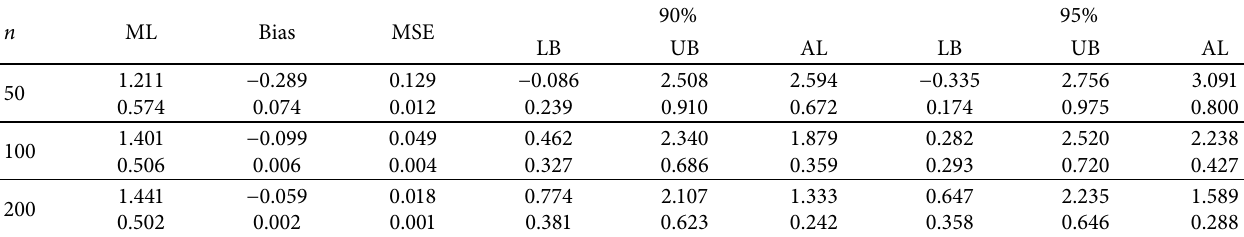
Table 1: ML estimates, biases, MSE, LB, UB, and AL of the TLIL model for α � 1.5, θ � 0.5.